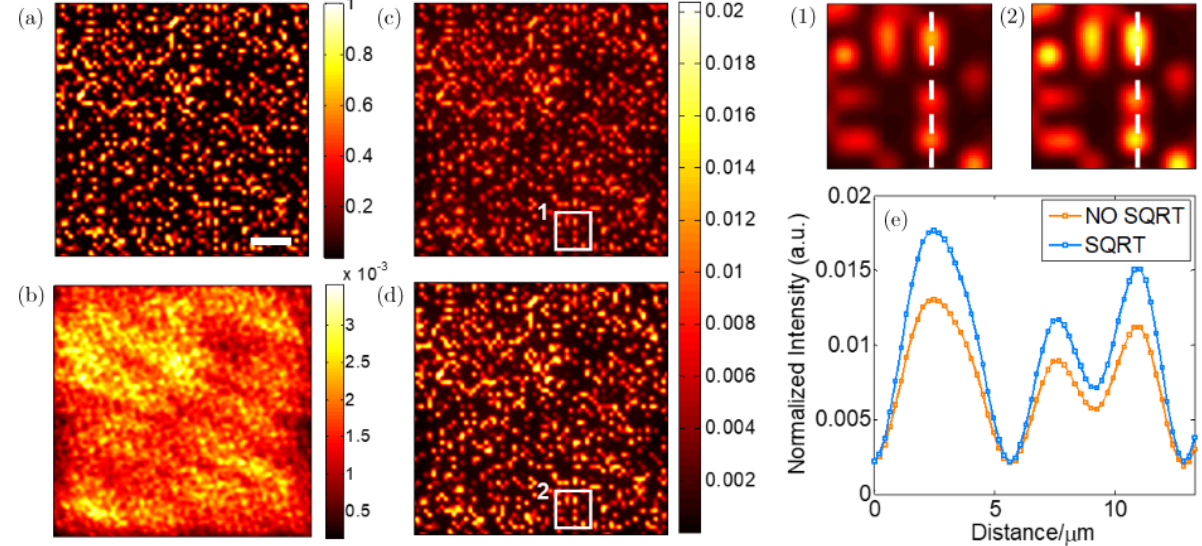
Fig. 5. (a) The ideal imaging of a single layer of randomly distributed °uorescent beads without the scattering medium (scale bar: 20 (cid:1) m). (b) The image distorted by the medium. (c) The corrected image using the conventional method. (d) The corrected image using our method. (1) The image part in the white square of (c). (2) The image part in the white square of (d). (e) The intensity pro¯les along the white dashed lines shown in (1) and